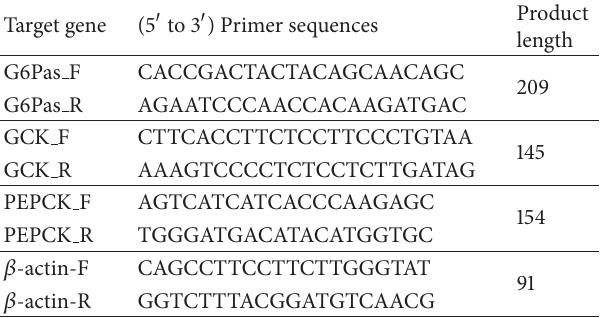
Table 2: mRNA primer design for the key metabolic enzymes in